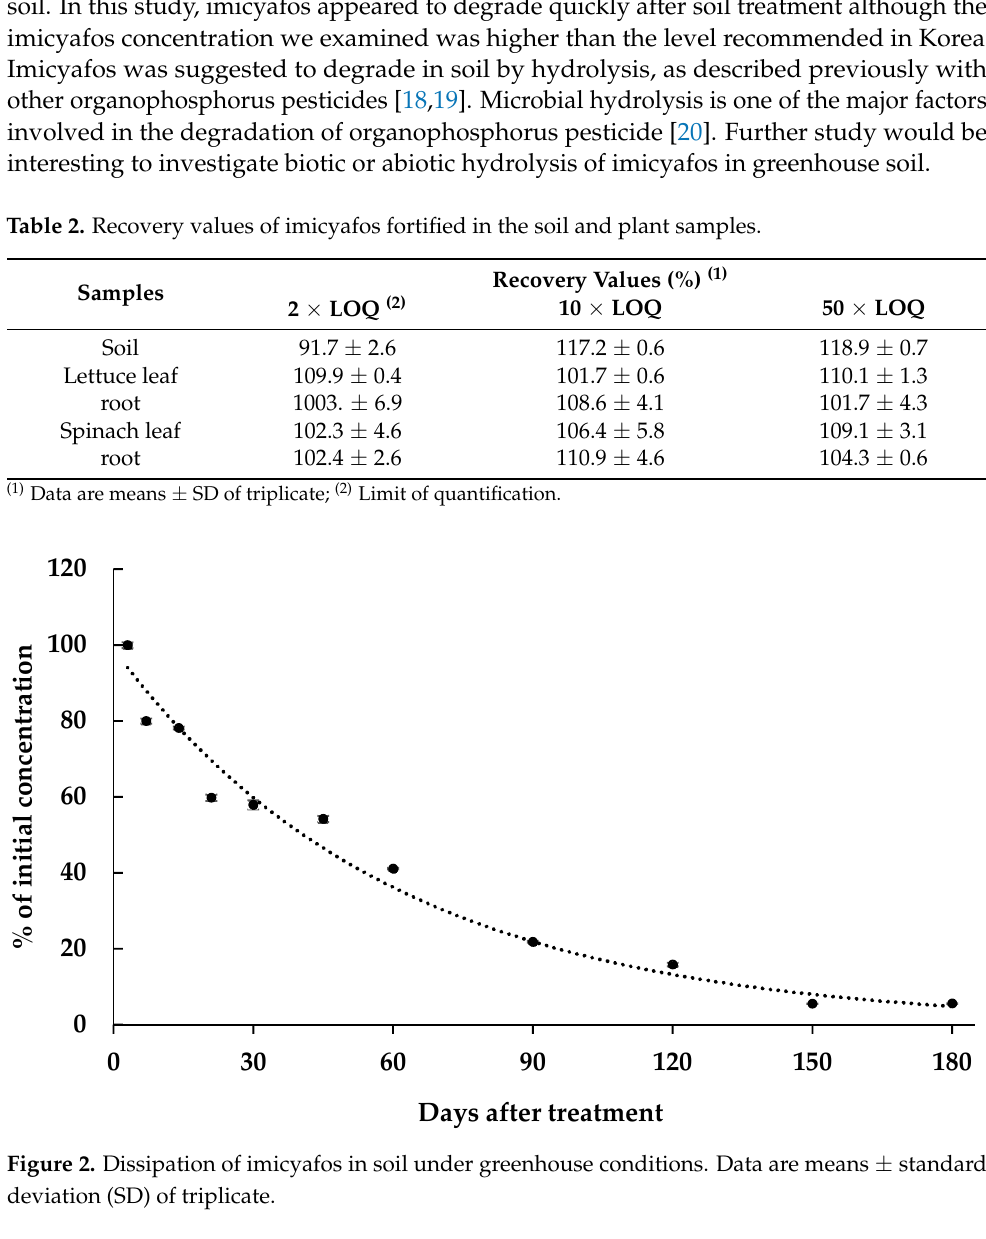
6 of 11 Table 2. Recovery values of imicyafos fortified in the soil and plant samples. Samples Recovery Values (%) (1) 2 × LOQ (2) 10 × LOQ